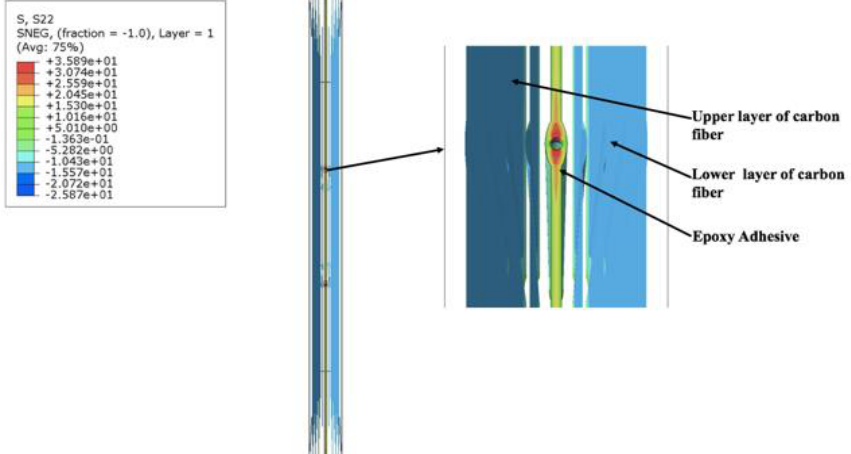
Figure 11. Stress distribution in the numerical model simulation with two FOSs in a linear placement with change in spacing.